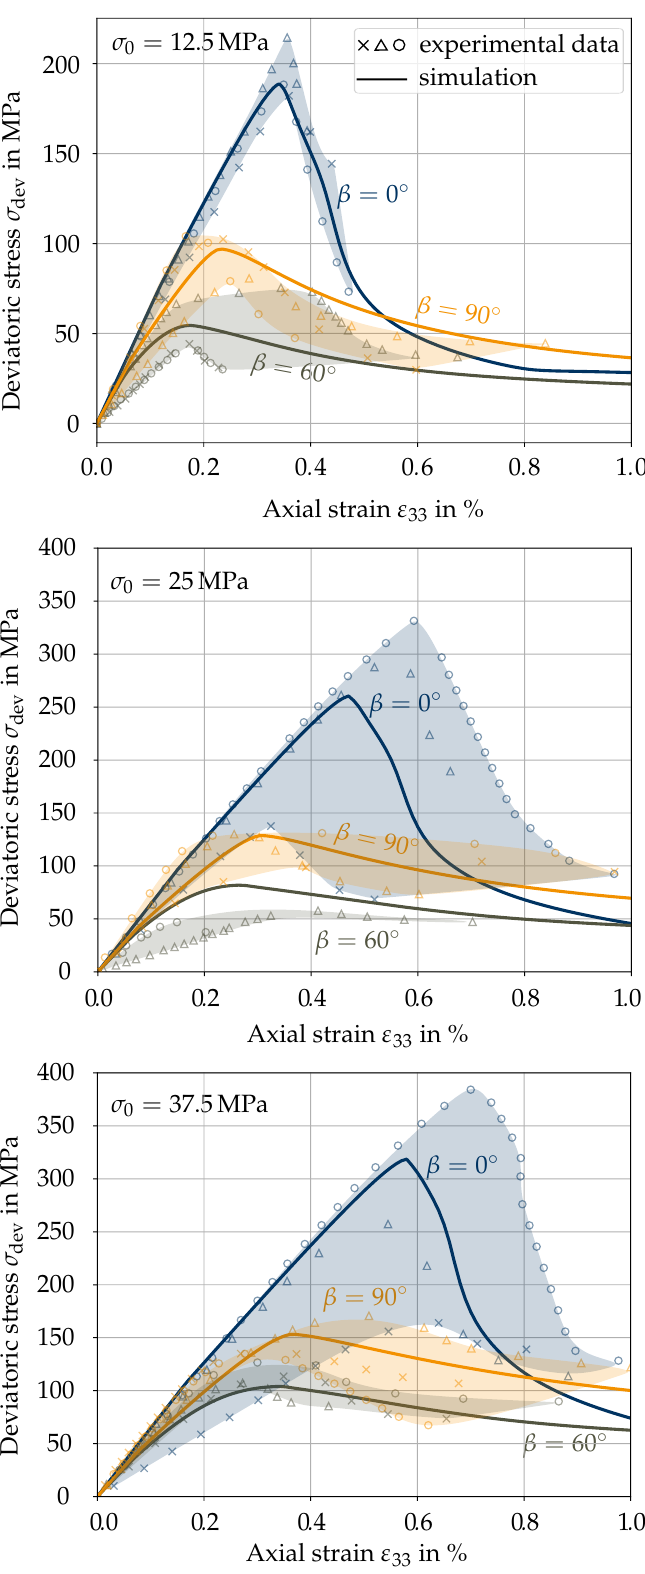
Figure 6. Computed deviatoric stress-strain curves of the triaxial compression tests for confining pressures of σ 0 = 12.5 MPa (top), 25MPa (middle) and 37.5 MPa (bottom).